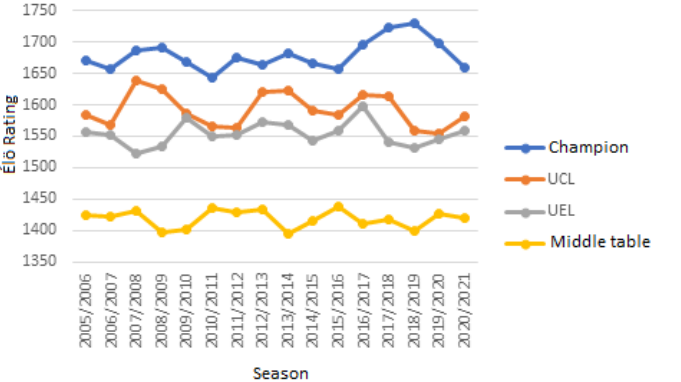
Figure 7. Evolution of the number of points needed to belong to each of the first four groups according to Algorithm 1.